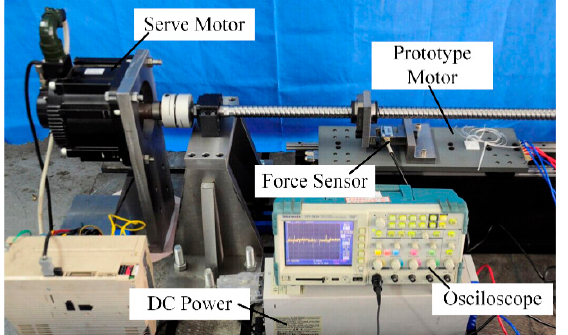
Figure 14. Test platform for linear synchronous motor. Reprinted with permission from ref. [86]. Copyright 2016 MDPI.